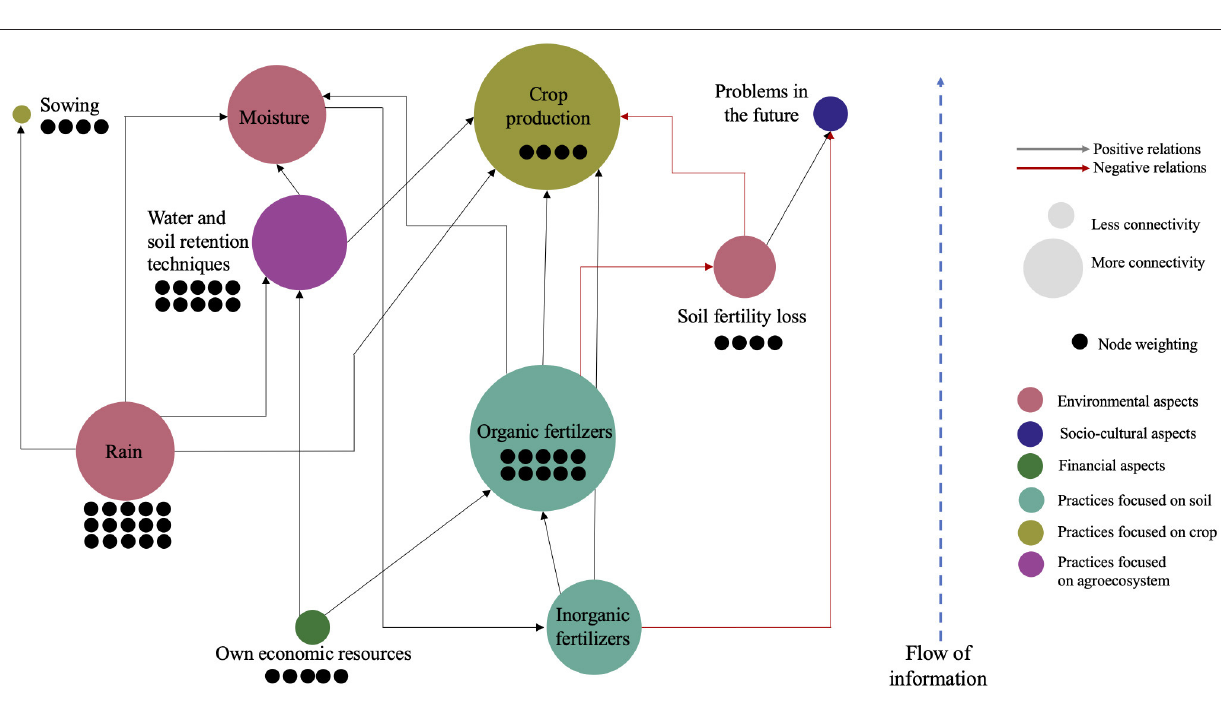
aspects (having MBP the highest proportion followed by CAP, CSO and finally FG with the lowest proportion). As for betweenness centrality ( Figure 9C ) the highest